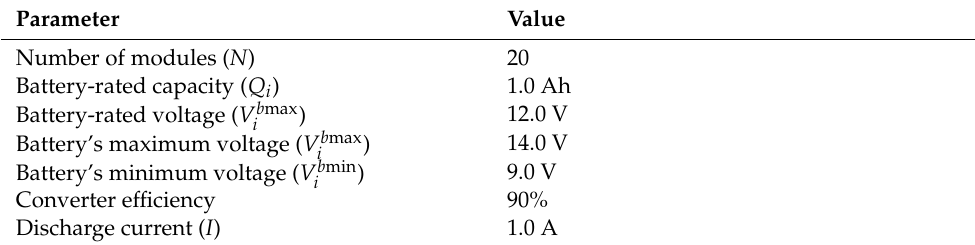
Table 2. System parameters employed in linear programming.